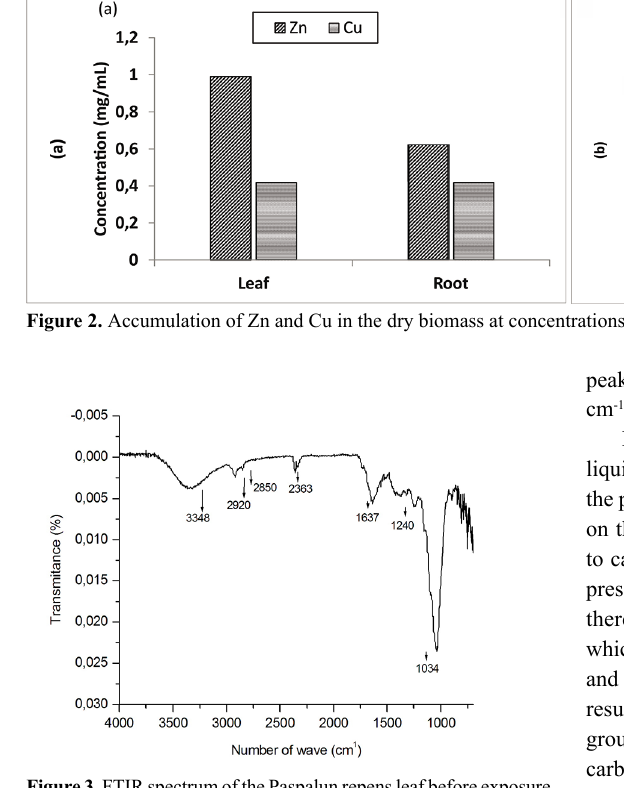
Figure 3. FTIR spectrum of the Paspalun repens leaf before exposure with the solution containing the